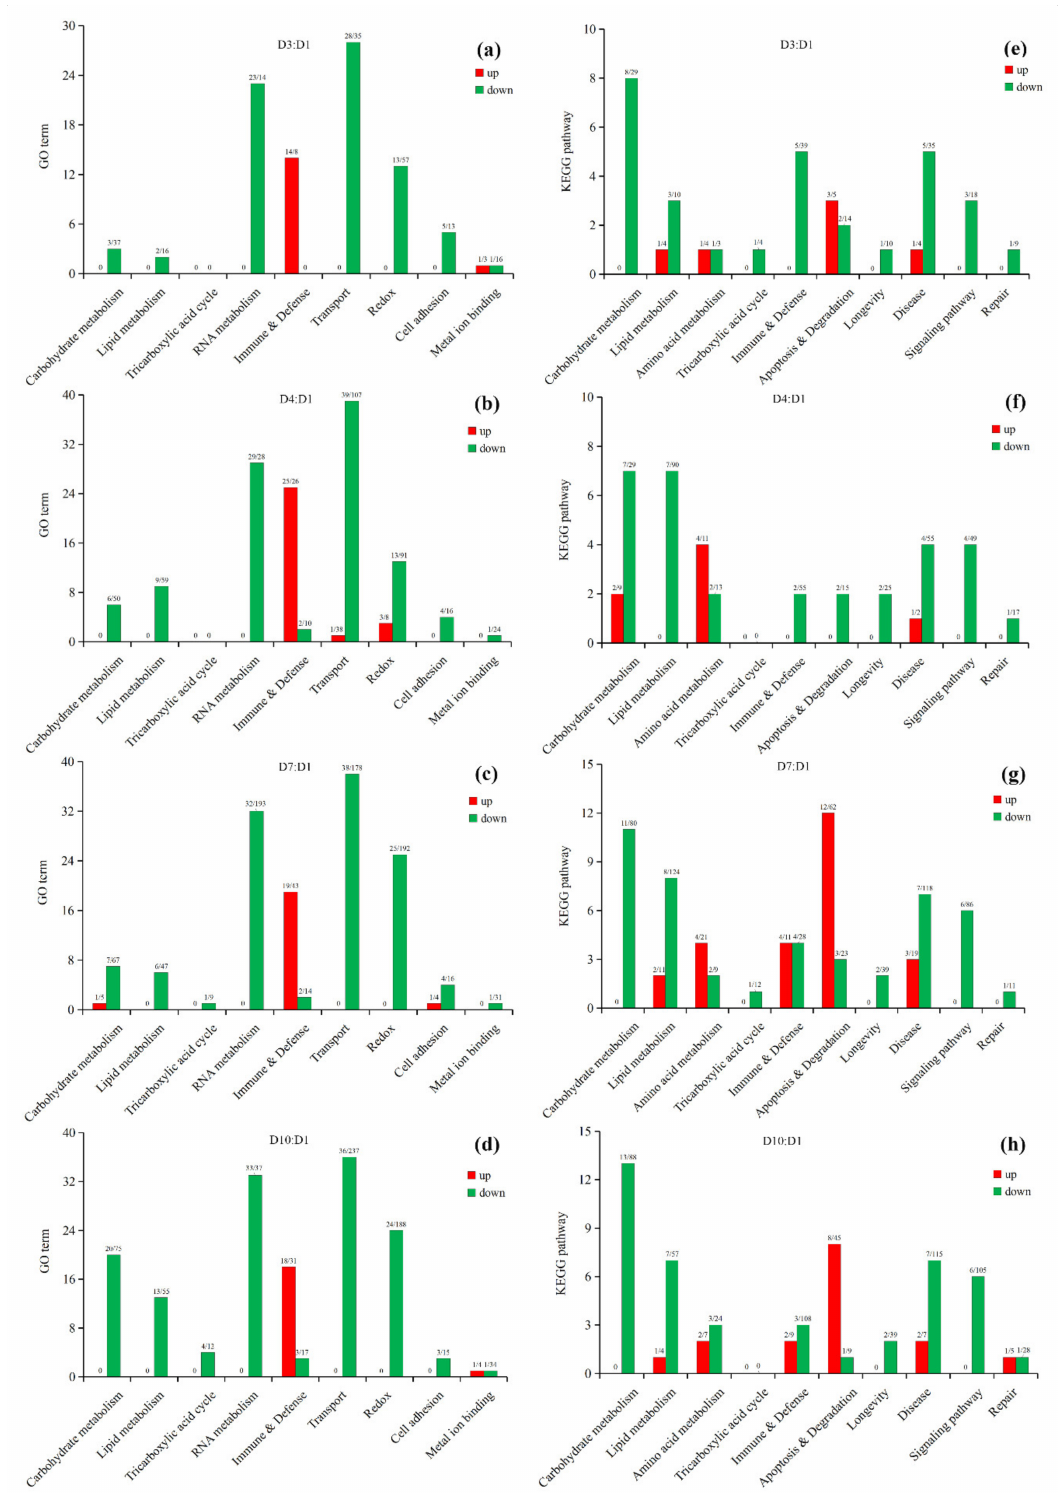
Figure 4. Enriched GO terms and KEGG pathways from the flight muscle of S. frugiperda females. ( a – d ) represent GO terms of D3:D1, D4:D1, D7:D1 and D10:D1 groups, respectively; ( e – h ) represent the KEGG pathways of D3:D1, D4:D1, D7:D1 and D10:D1 groups, respectively. Red columns represent terms or pathways enriched to upregulated DEGs and green columns represent terms or pathways enriched to downregulated DEGs. Upon the columns, the first number represents the number of terms or pathways, and the second number represents the number of